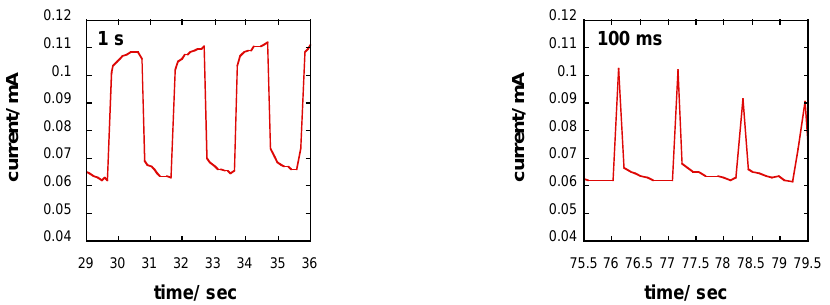
Figure 10. The response of the photodiode to light pulses with a forward bias voltage of 5 V.